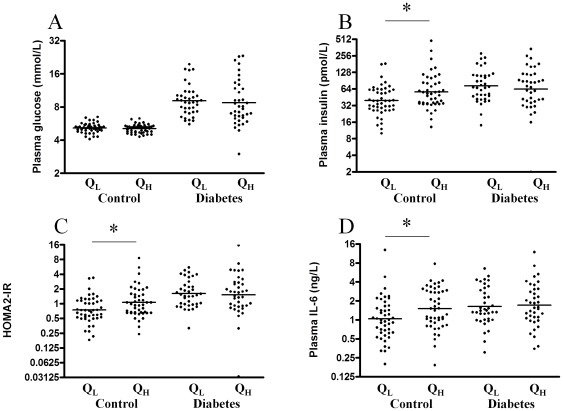
Muscle myostatin mRNA divided in low (QL) and high (QH) content in control subjects and patients with type 2 diabetes, respectively.The bar represents geometric means for plasma (A), plasma insulin (B), HOMA2-IR (C) and plasma IL-6 (D). * indicates a difference between low versus high muscle content of myostatin mRNA. P<0.05 is considered significant.